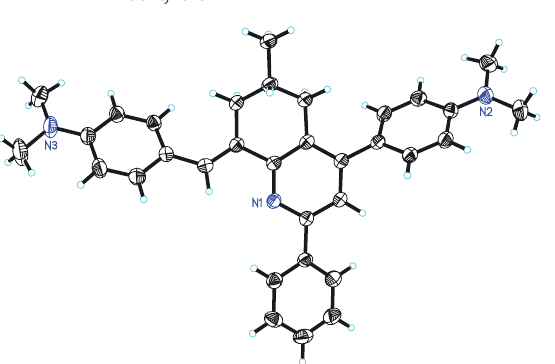
Figure 2. Molecular structure of the compound 6a with 30% prob- ability level.